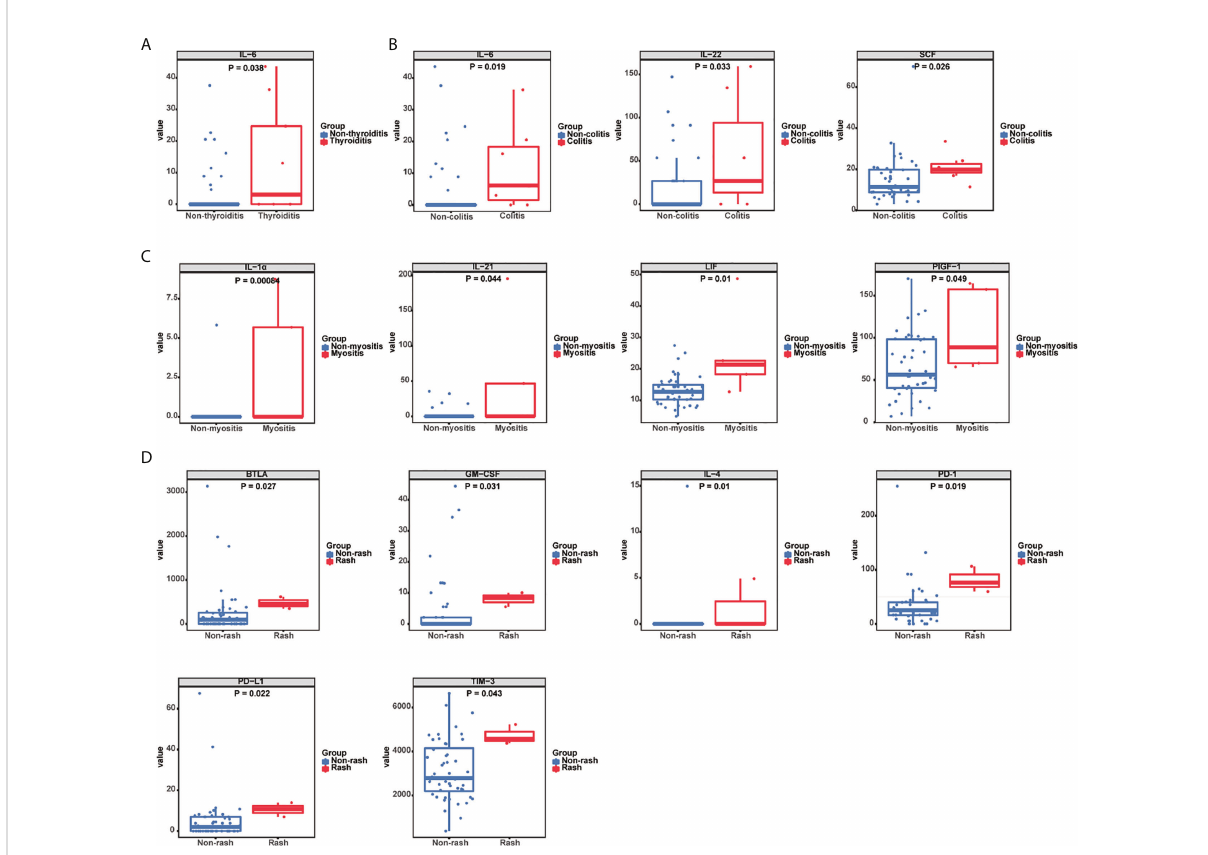
FIGURE 2 Association between serum cytokine levels and organ-speci fi c irAEs. (A) Box plots representing serum IL-6 levels (pg/mL) in thyroiditis (n = 9) and non-thyroiditis (n = 42) patients. (B) Box plots representing serum IL-6, IL-22, and SCF levels (pg/mL) in colitis (n = 7) and non-colitis (n = 44) patients. (C) Box plots representing serum IL-1 a , IL-21, LIF, and PIGF-1 levels (pg/mL) in myositis (n = 5) and non-myositis (n = 46) patients. (D) Box plots representing serum BTLA, GM-CSF, IL-4, TIM-3, PD-L1, and PD-1 levels (pg/mL) in patients with (n = 3) and without rash (n = 48). The median of each group and P-value were calculated using the Mann-Whitney U test (P <